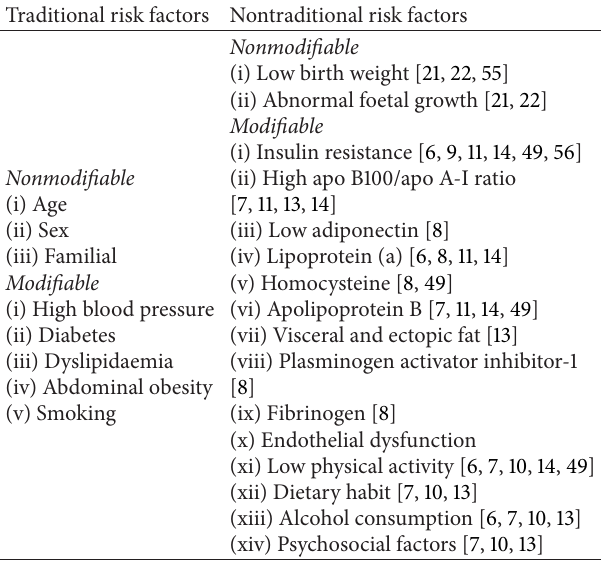
Table 2: Widely distributed cardiovascular disease risk factors among South